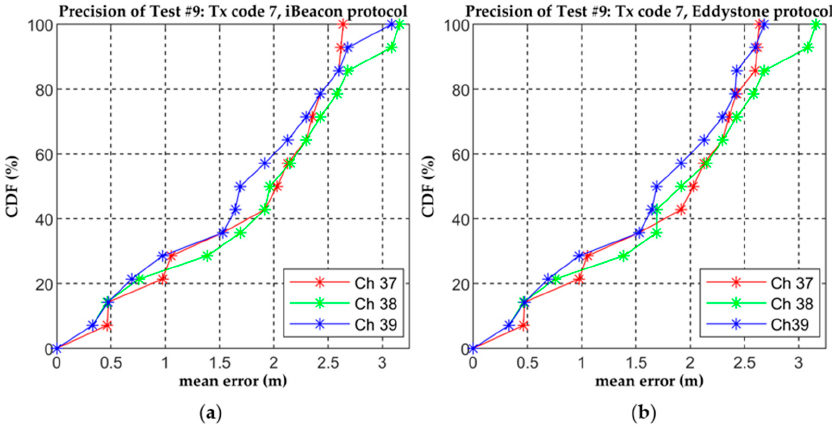
Figure 11. Precision of Test #9 for Tx code 7, three advertising channels and ( a ) iBeacon protocol and ( b ) Eddystone protocol. Table 23. Main features of Tests #9.